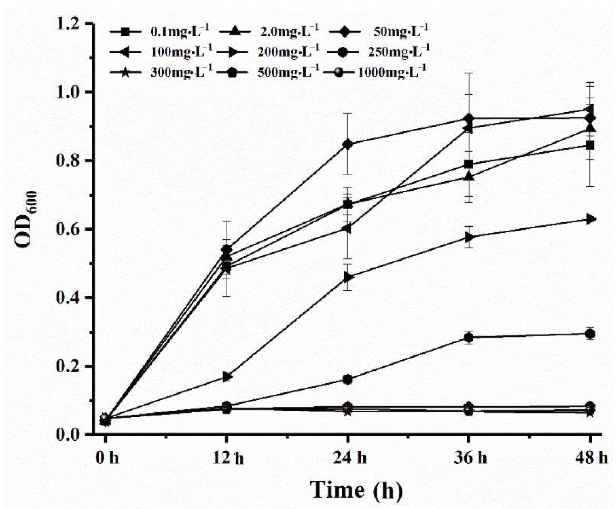
Figure 4. The growth curves of strain SC16 under different nitrite concentrations.